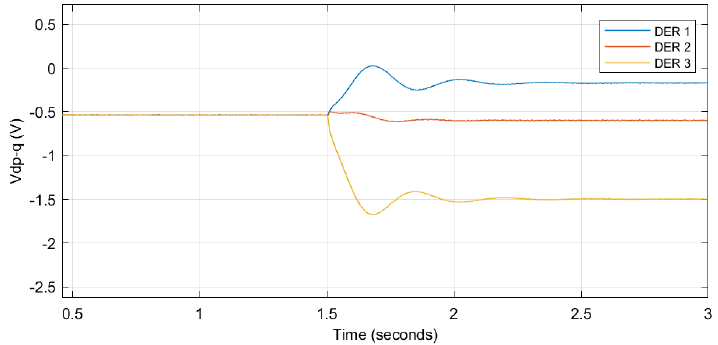
Figure 6. v dpq drop in voltage due to typical virtual impedance.